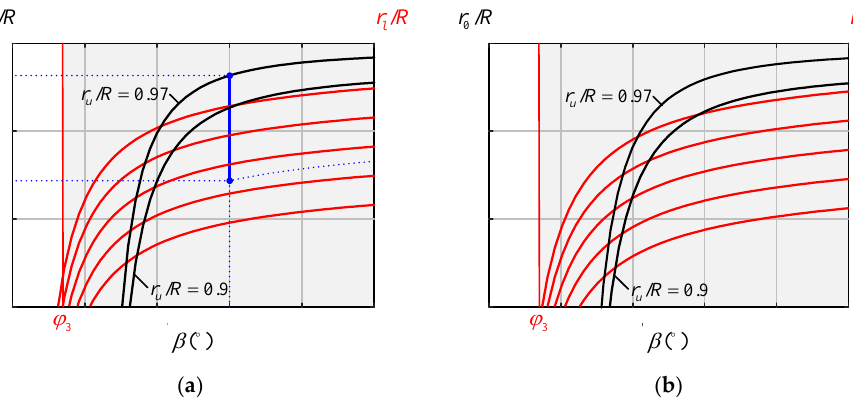
According to Equations (48) and (51), the variation in r l / R versus r 0 / R and β is demon- strated in Figure 19. Herein, red solid lines, as the lower bounds, correspond to contour curves of different values of r l / R ; black solid lines, as the upper bounds, are plotted through Equation (48).